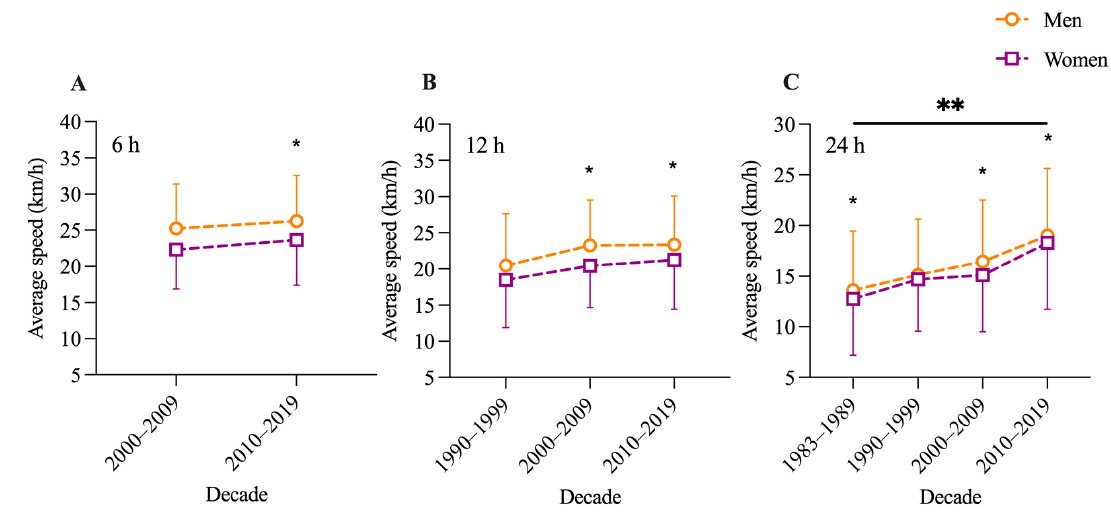
Figure 3. Average speed (km/h) of men and women, subdivided into 6 ( A ), 12 ( B ) and 24 h ( C ) races and decade. Data expressed as mean and standard deviation. *: difference between sexes within specific decade. **: difference between each decade.